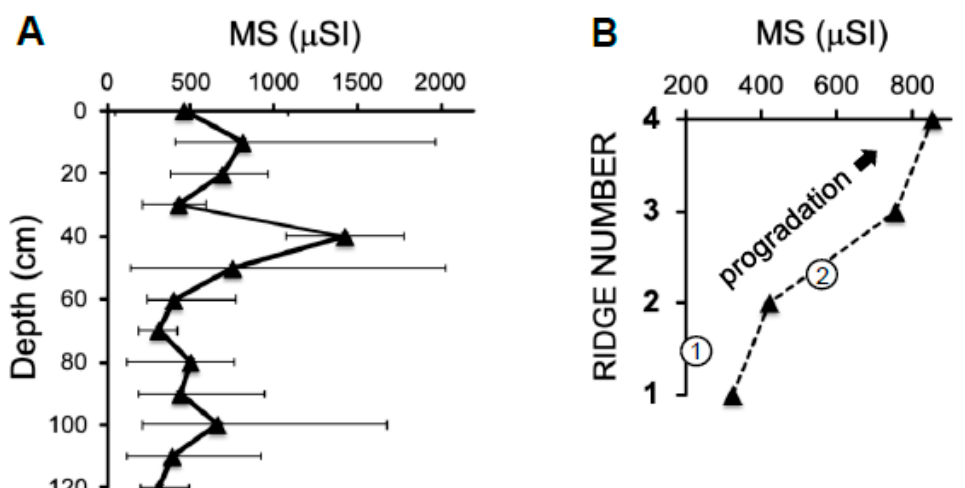
Figure 4. Vertical (trench/core stratigraphic) and lateral (morphostratigraphic) trends. ( A ) Mean val- ues and ranges of trench and outcrop-based in situ MS values from four ridges (R1-R4). Note a well- constrained high MS anomaly at a 0.4 m depth. ( B ) Mean values of each ridge reveal an increasing trend in a morphostratigraphically younger direction, with the most recent R4 having a >2.5 higher mean MS compared to R1. Two cores (KII-1 and 2) are shown as circles for comparison; however, they have a much greater range of variations due to the presence of both organics and deep HMCs.